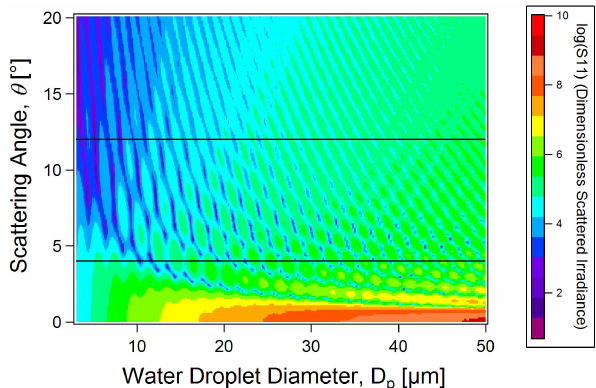
Fig. A1. Logarithm of the dimensionless scattered irradiance (S11) as a function of scattering angle and droplet diameter, from Mie